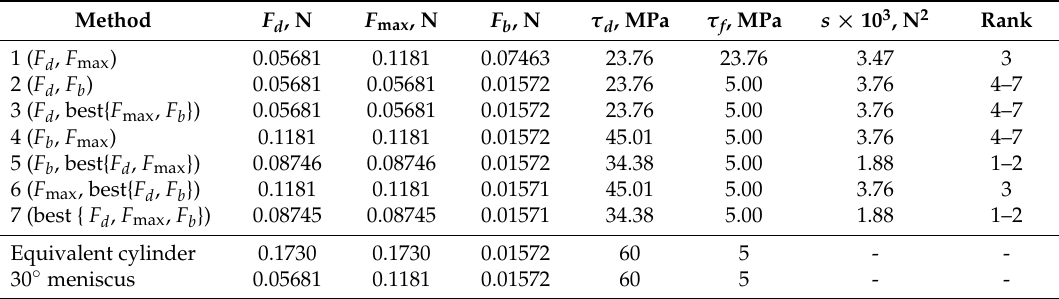
Table 3. Interfacial strength parameters determined from a theoretical force–displacement curve for E-glass fiber–epoxy matrix pair using different